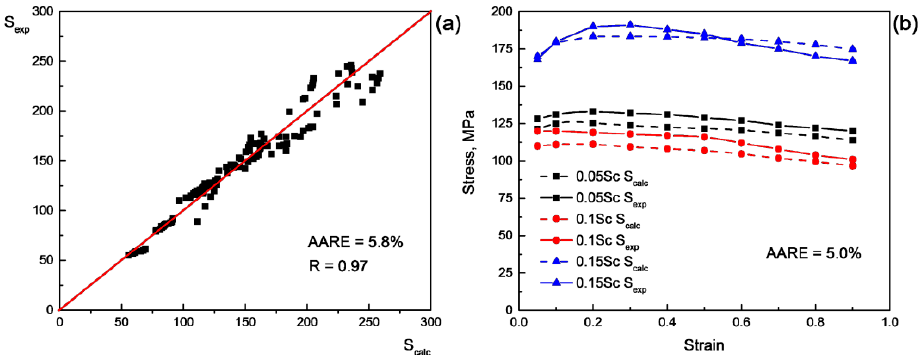
Figure 3. The comparison between experimental and calculated values of stress ( a ) and model validations using additional experiments at different temperature and strain rate conditions ( b ): alloy 0.05Sc – 375 °C and 0.05 s − 1 ; alloy 0.1Sc – 425 °C and 1.5 s − 1 ; alloy 0.15Sc – 325 °C and 0.8 s − 1 .